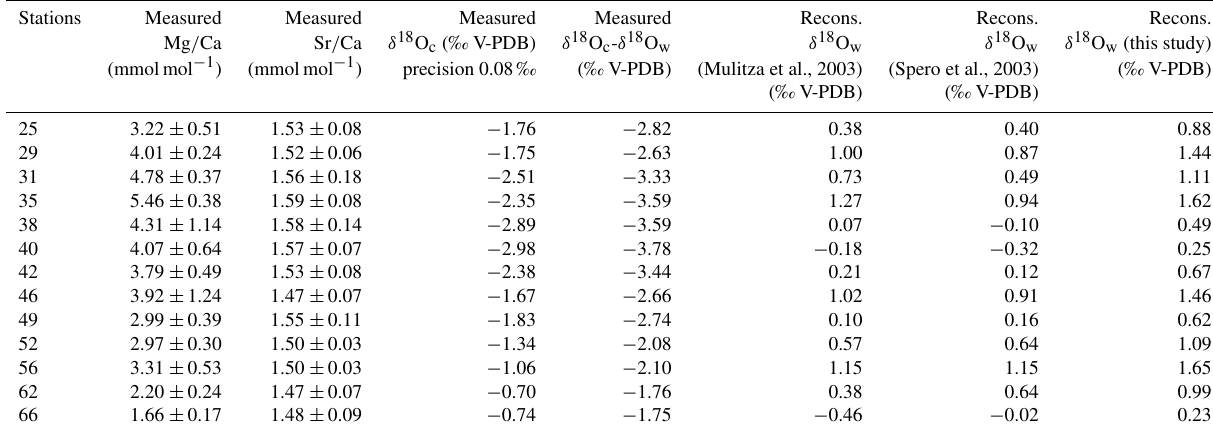
Table 2. Mean elemental (Mg / Ca and Sr / Ca) and isotopic ( δ 18 O c ) composition per station measured in foraminiferal calcite in millimoles per mole (mmolmol − 1 ) and per mille PDB (‰ PDB), respectively. Elemental and isotopic compositions were determined on the same material ( n varying from 5 to 13 specimens per station). Isotopic analyses were done in duplicate for each station. Mean δ 18 O c - δ 18 O w were measured per stations in per mille PDB (‰